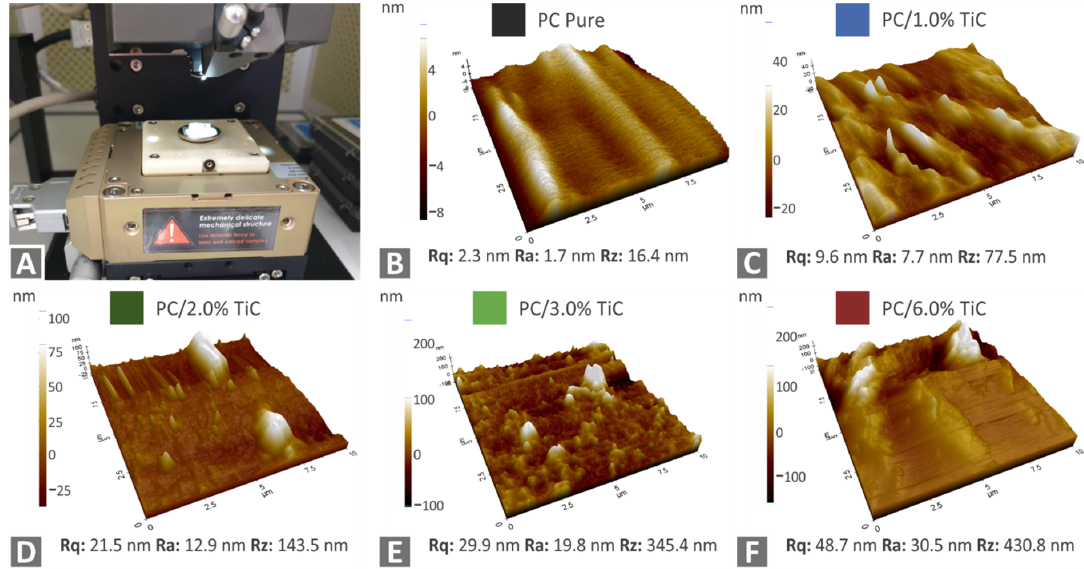
Figure 7. Surface quality measurements with AFM on the produced filament: ( A ) AFM experimental setup, ( B ) pure PC, ( C ) PC/TiC 1 wt.%, ( D ) PC/TiC 2 wt.%, ( E ) PC/TiC 3 wt.%, and ( F ) PC/TiC 6 wt.%.